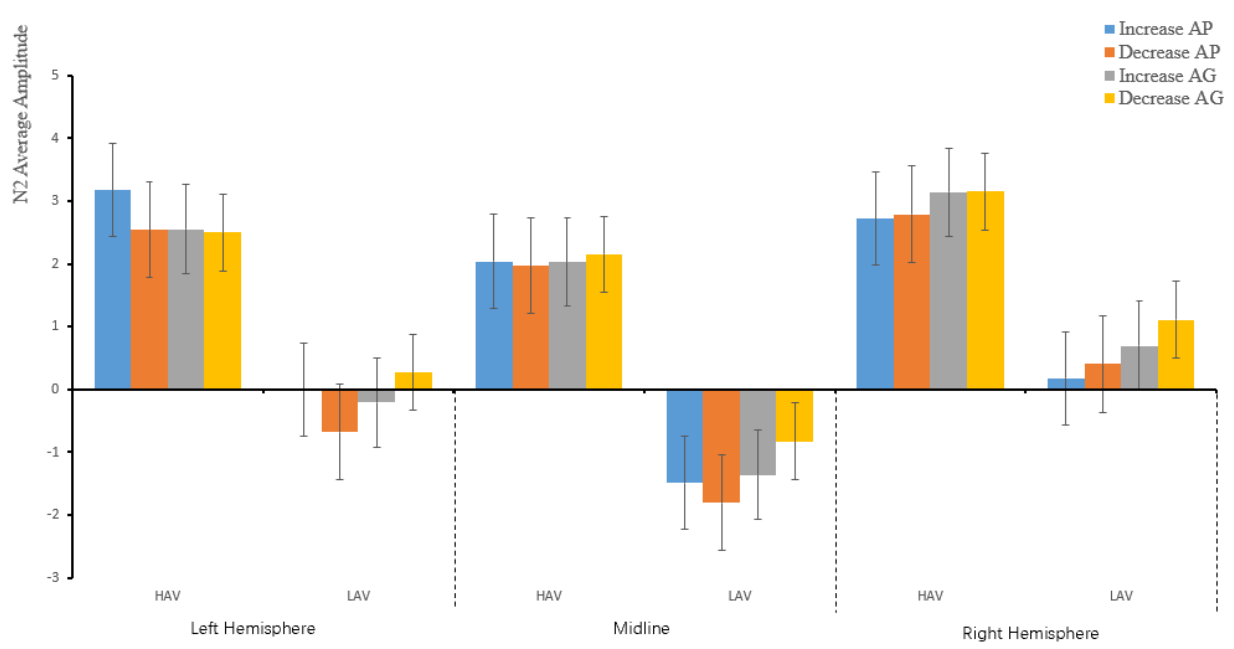
Figure 6. The descriptive statistics bar graph of the average amplitude of N2 about the hemisphere and emotion regulation. Table 6. N2 amplitudes (mean and standard error).